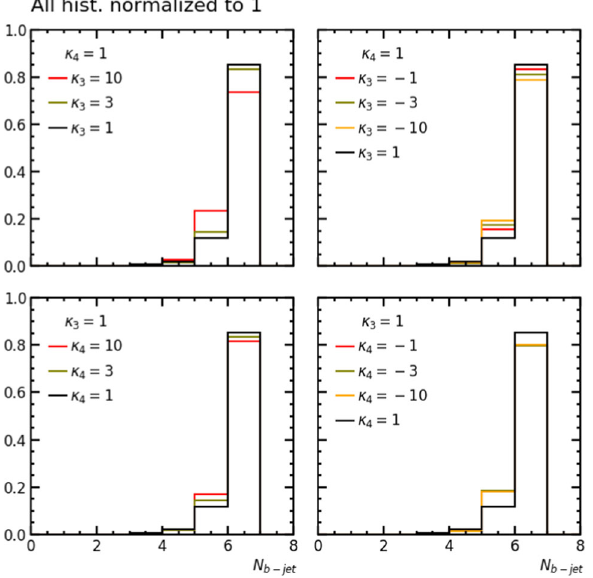
Fig. 33 Distribution of e + e − → b ¯ bb ¯ bb ¯ b ν ¯ ν events with respect to the angular separation between b -jets, for several values of the parameters κ κ 3 and 4